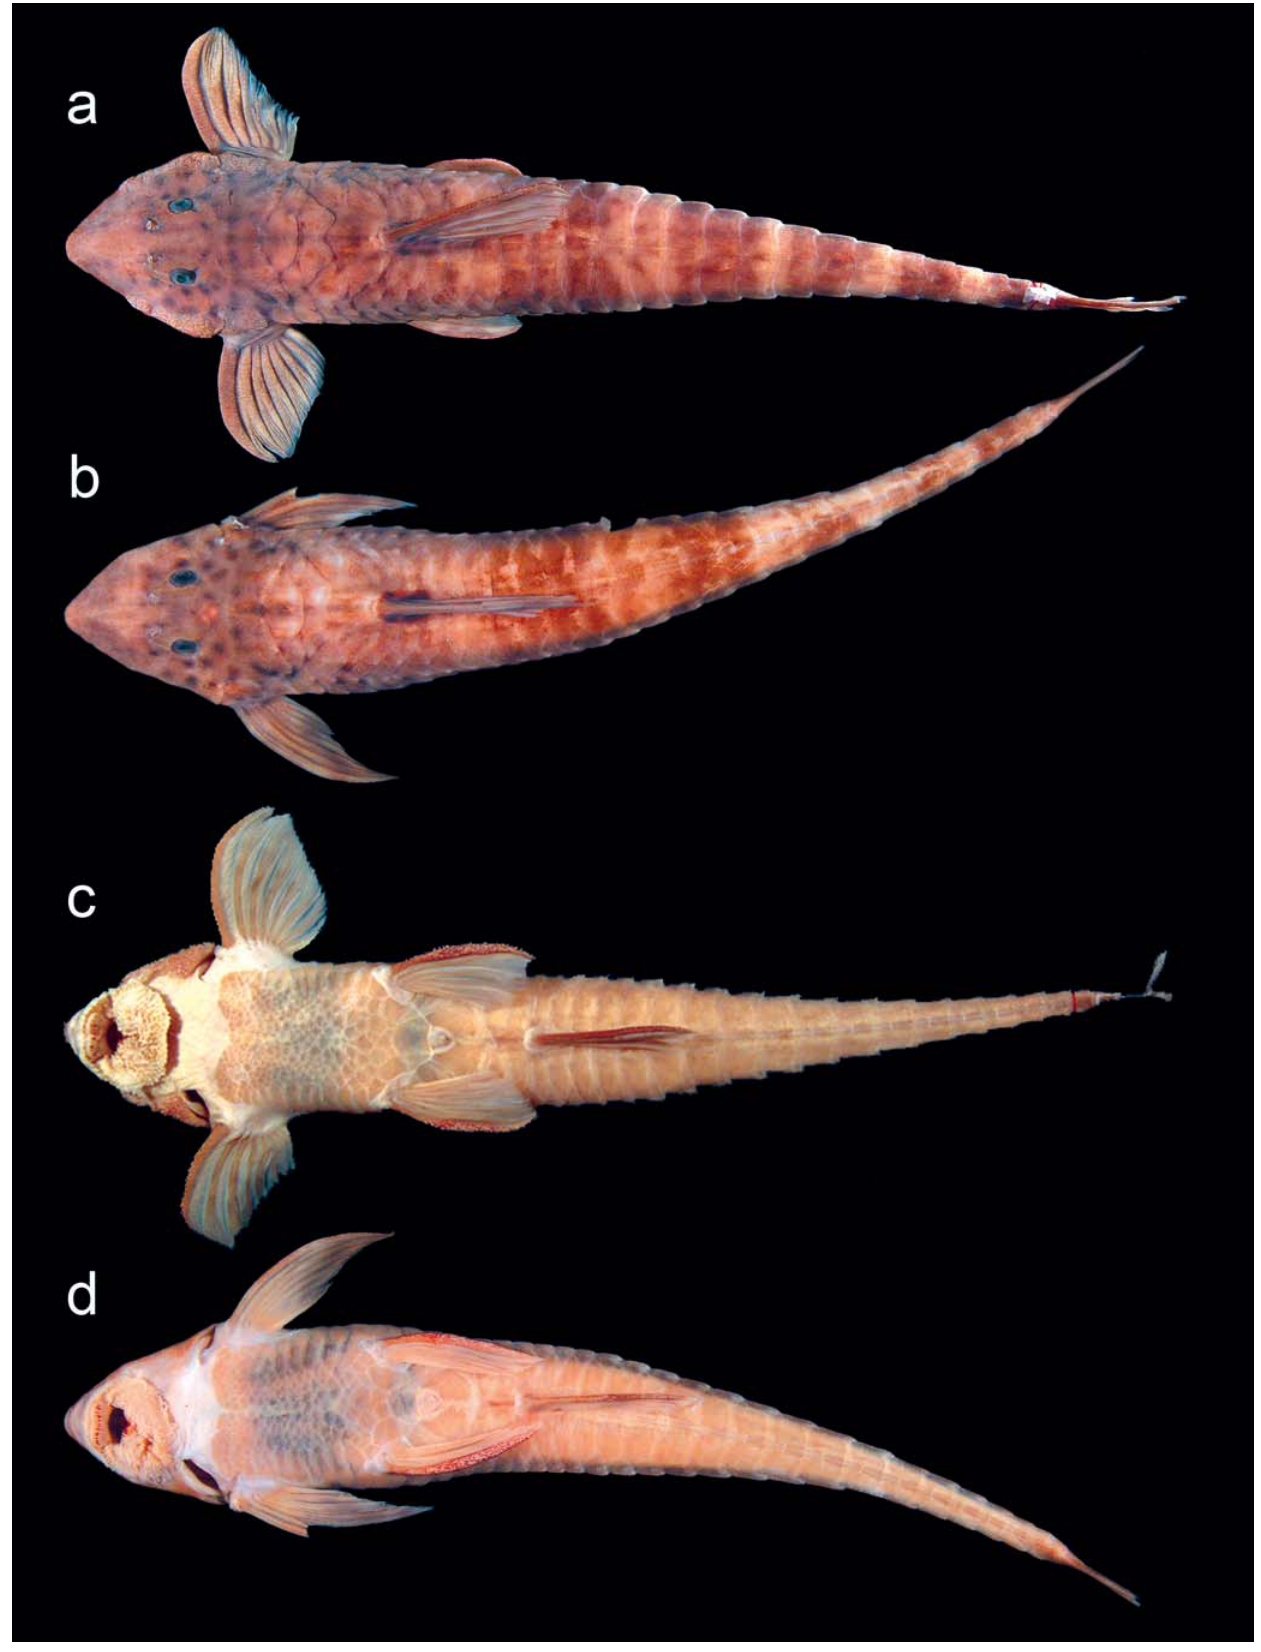
Fig. 2. Rineloricaria daraha . Paratypes, male ( a and c = INPA 6586; 186.8 mm SL), female ( b and d = INPA 6586; 131.2 mm